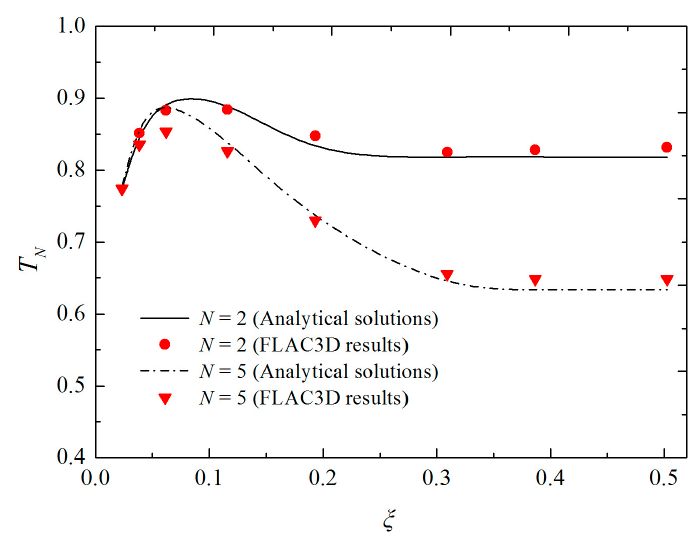
Figure 4. Relations between transmission coefficient T N and dimensionless fracture spacing ξ for normally incident P wave transmission across a joint set.